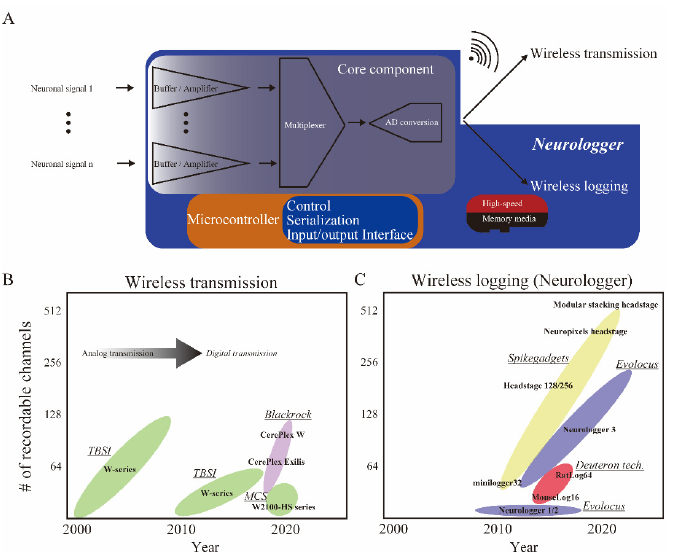
Figure 1. Innovation of wireless devices for neuronal activity. ( A ) Simplified diagram of wireless neuronal recording devices. A core component (ex. RHD2000/RHA2000 chips, Intan Technologies, Los Angeles, CA, USA) and microcontroller (custom AISC or FPGA) are implemented in both wireless transmission and logging devices. After a core process consisting of buffering, amplifying, and multiplexed AD conversion, wireless logging devices called neurologgers directly store signals in the tiny memory media inside the device (enclosed within the blue shaded area), whereas wireless transmission types transmit signals to a desktop server (top right). ( B , C ) Timelines of the development of wireless devices. ( B ) Wireless transmission devices have been available since the 2000s. After ca. 2010, neuronal activity could be digitized before being transmitted. ( C ) Neurologgers have been available since the 2010s. The number of recordable channels is progressively increasing for neurologgers. Vendors have been listed and underlined in italics. Only representative products were listed within the color-coded ellipse for each vendor. TBSI: Triangle BioSystems International, USA; MCS: Multi Channel Systems, Germany; Blackrock: Blackrock Neurotech, UT, USA; Deuteron tech: Deuteron Technologies, Israel; Evolocus: Evolocus, NY, USA; SpikeGadgets: SpikeGadgets, CA,